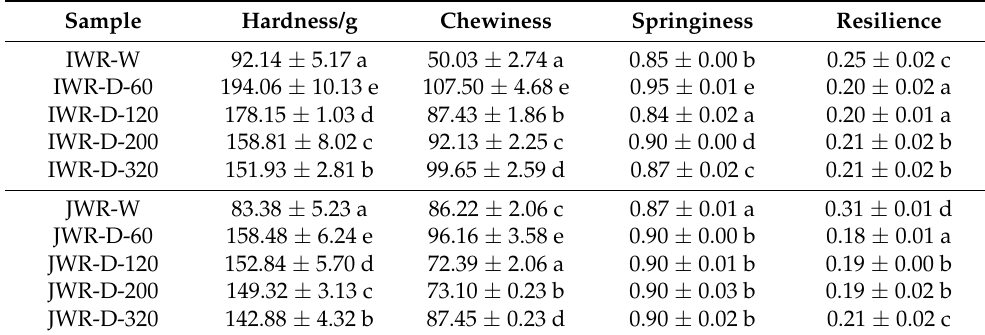
Table 4. Texture properties of waxy rice balls.